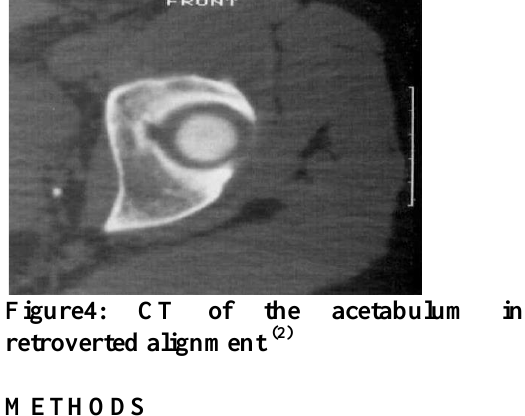
Figure4: CT of the acetabulum